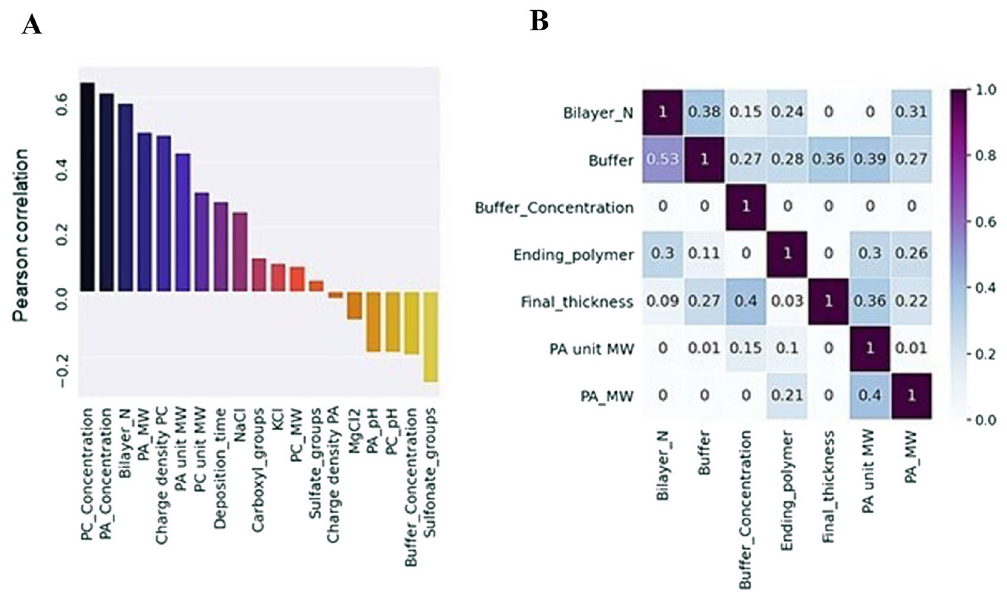
Figure 3. Pearson correlation ( A ) and Predictive Power Scores (PPS) ( B ) calculated for the final thickness of the coating and coating features. The first seven Pearson correlations are statistically significant ( p ≤ 0.05). Only features having PPS > 0.001 with the target value are included. Full names of polymer features are provided in SI Table